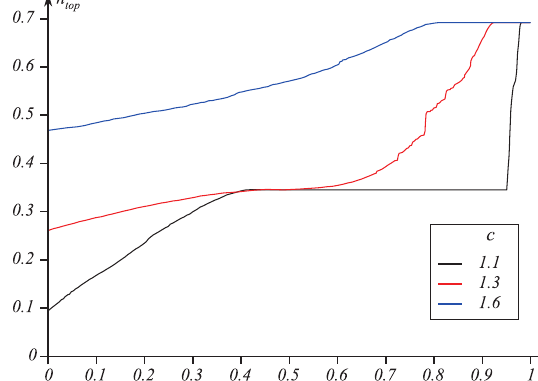
Fig. 12 The graph of topological entropy with respect to parameter ε